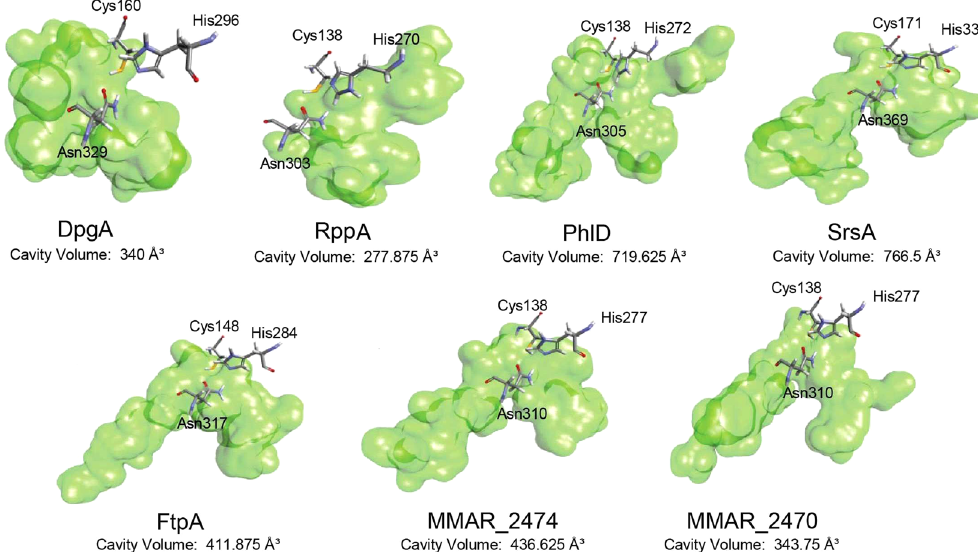
Figure 2. Homology modeling and comparison of ligand/product binding cavities of MMAR_2470 and MMAR_2474 proteins with experimentally characterized bacterial type III PKSs. Homology models of the type III PKSs were generated using Biovia Discovery Studio 4.5. The homology models along with x-ray crystallographic structure of RppA (PDB id 1U0M_B) were probed for differences in architecture and volumes of the product binding cavities in each protein. The Cys , His and Asn catalytic triad is shown along with the identified cavity. Cavity volumes (in Å 3 ) are mentioned below the protein names.